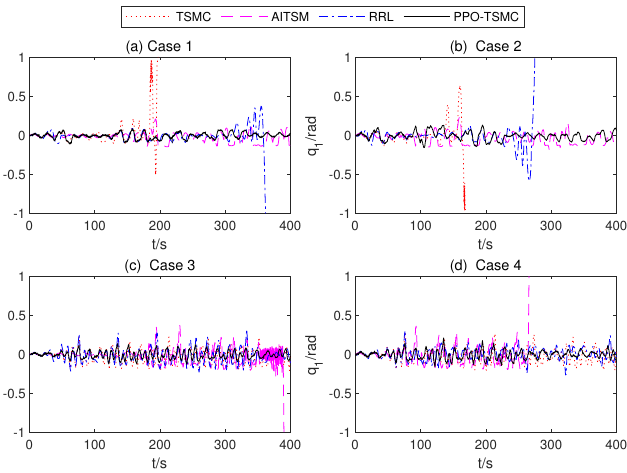
Figure 11. Roll anglesof four different controllers.